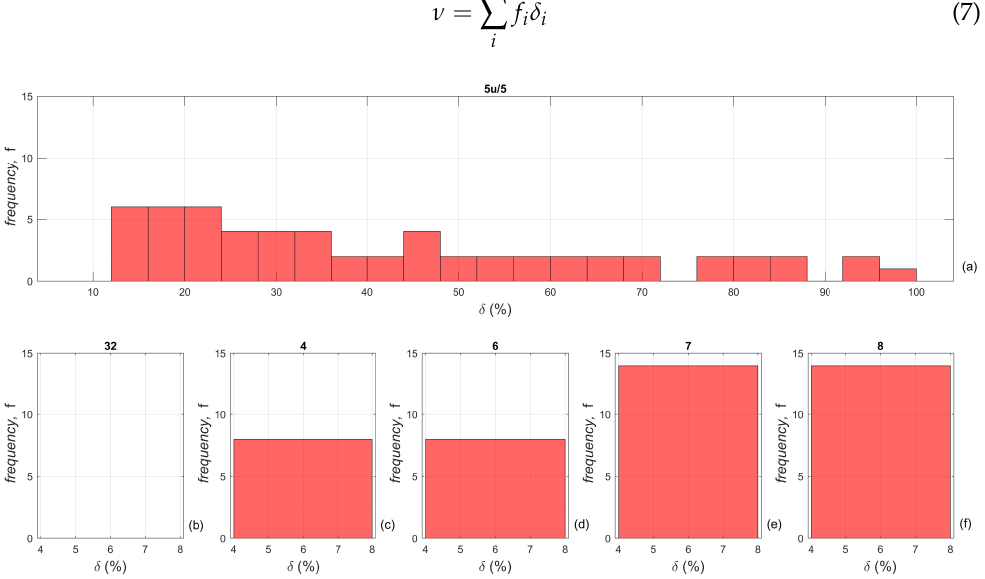
Figure 8. Frequency distribution of the relative amplitude of the pressure waves given by the LM for test #1 at measurement sections: ( a ) 5u and 5; ( b ) 32; ( c ) 4; ( d ) 6; ( e ) 7; ( f )